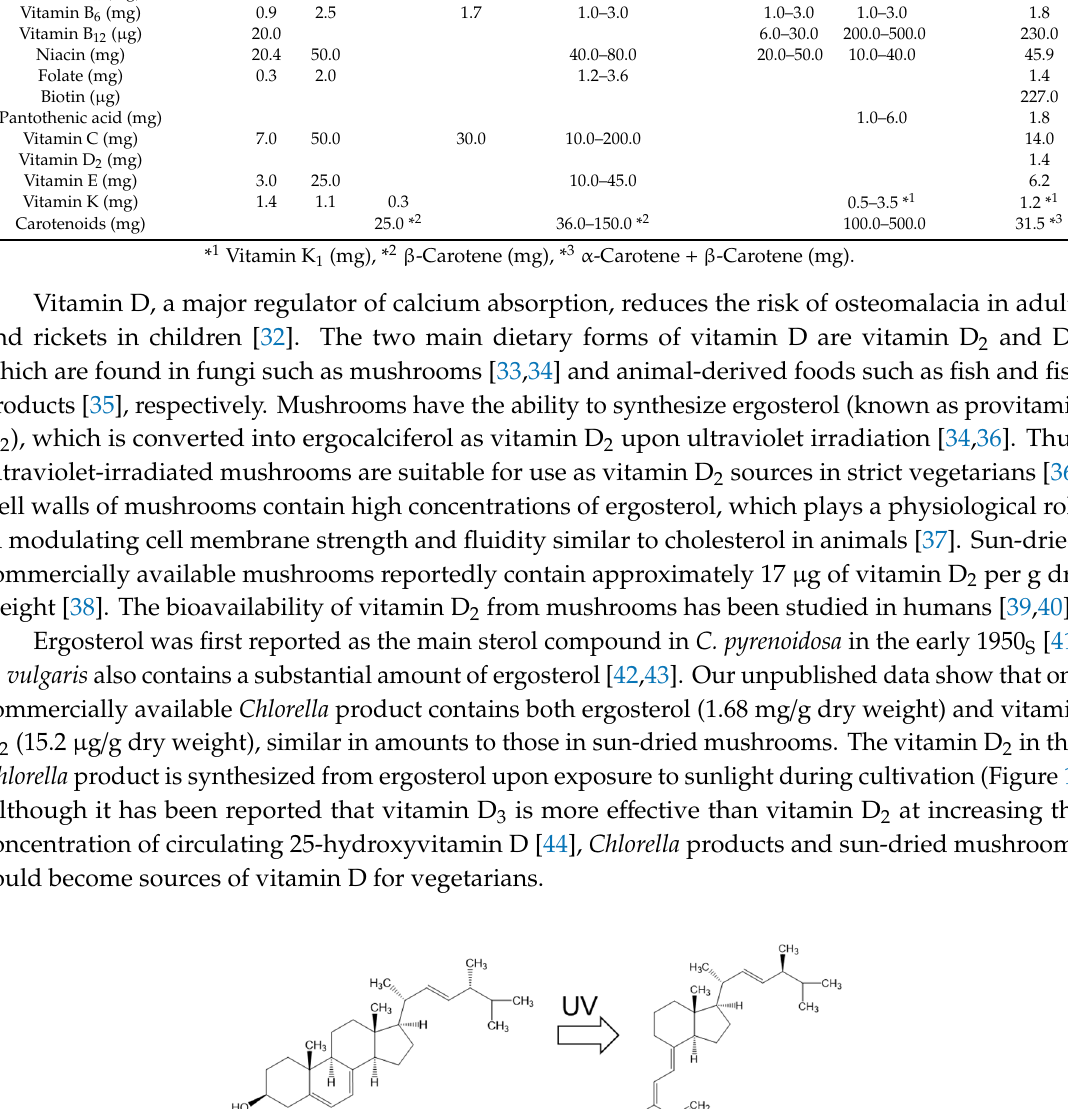
Table 3. Content of vitamins and related compounds in 13 commercially available Chlorella products. Vitamins